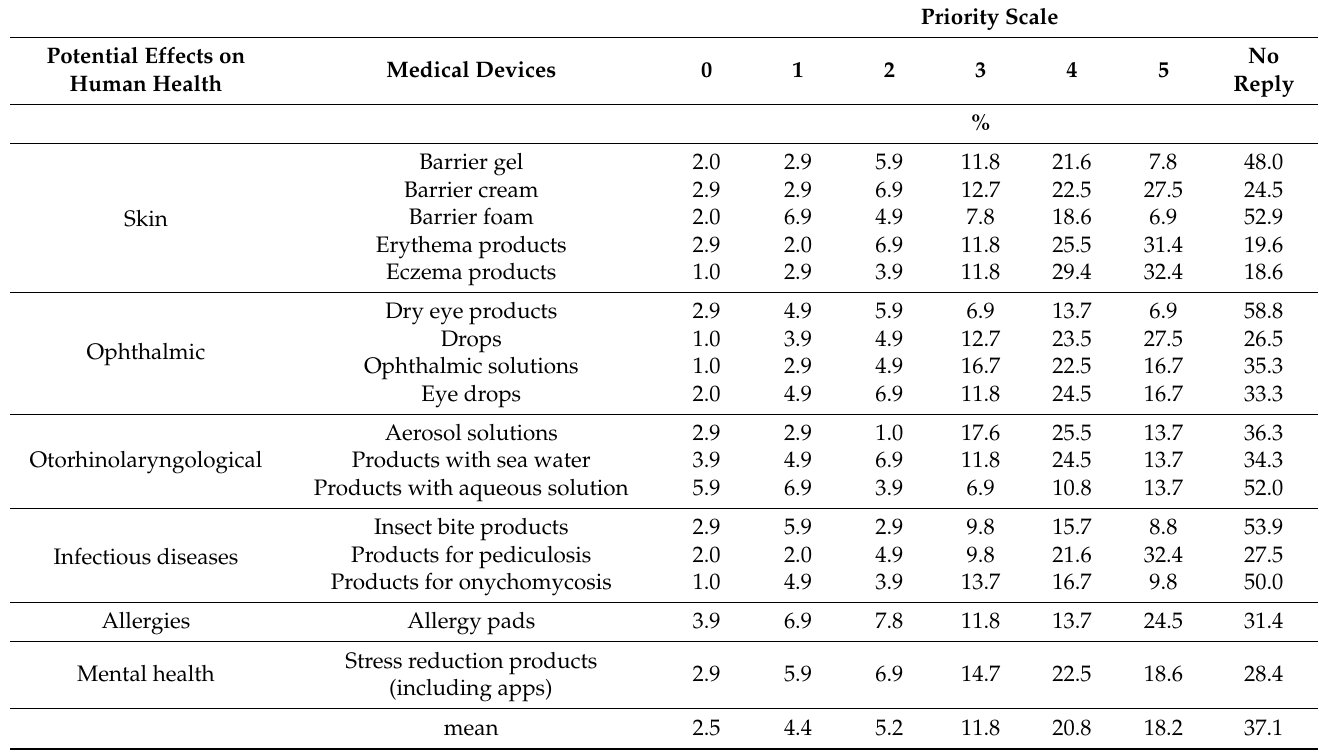
Table 3. Percentages of answers given by doctors (general practitioners or primary care physicians) about which medical devices can mitigate the effects of GEC on human